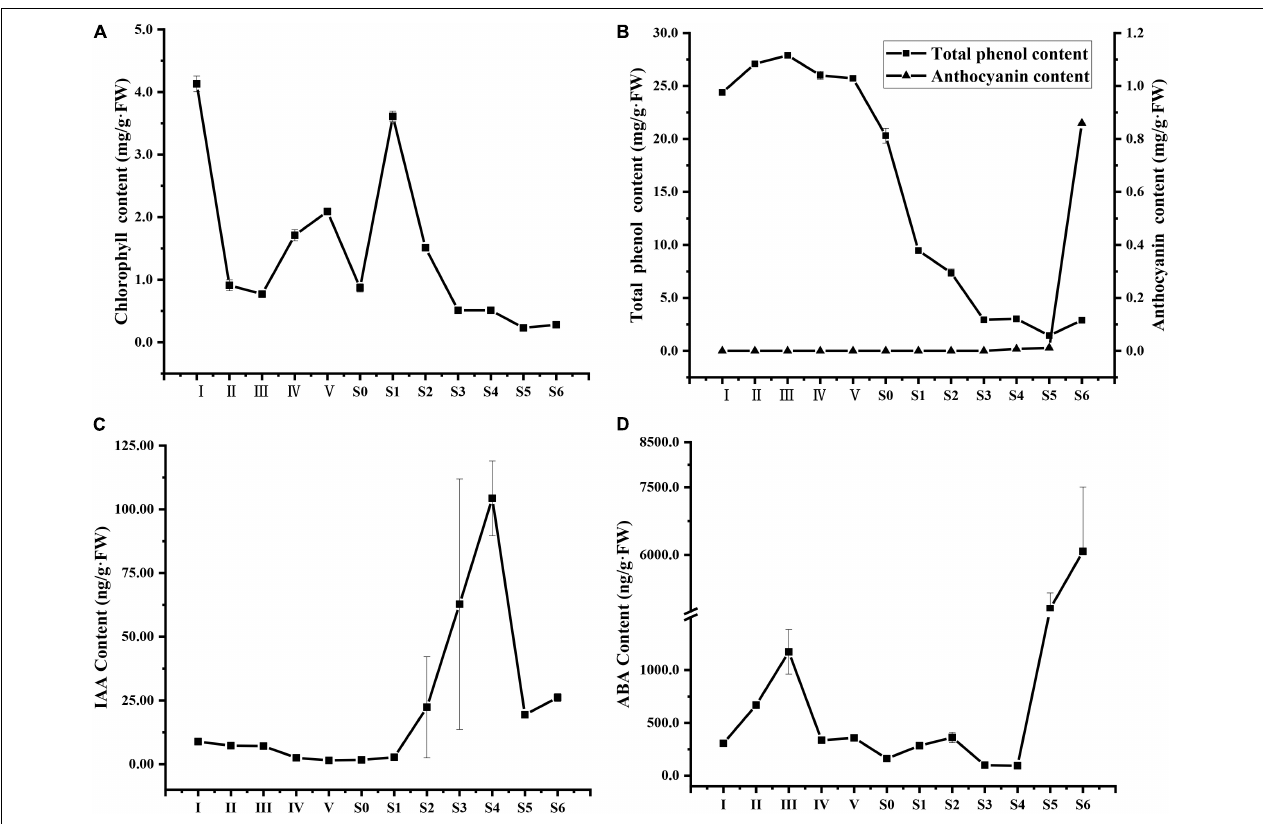
FIGURE 2 | Changes in the chlorophyll (A) , total phenol and anthocyanin (B) , IAA (C) and ABA (D) contents of V. corymbosum ‘O’Neal’ flower bud and fruit throughout development. Error bars represented the SD of three-to-six independent